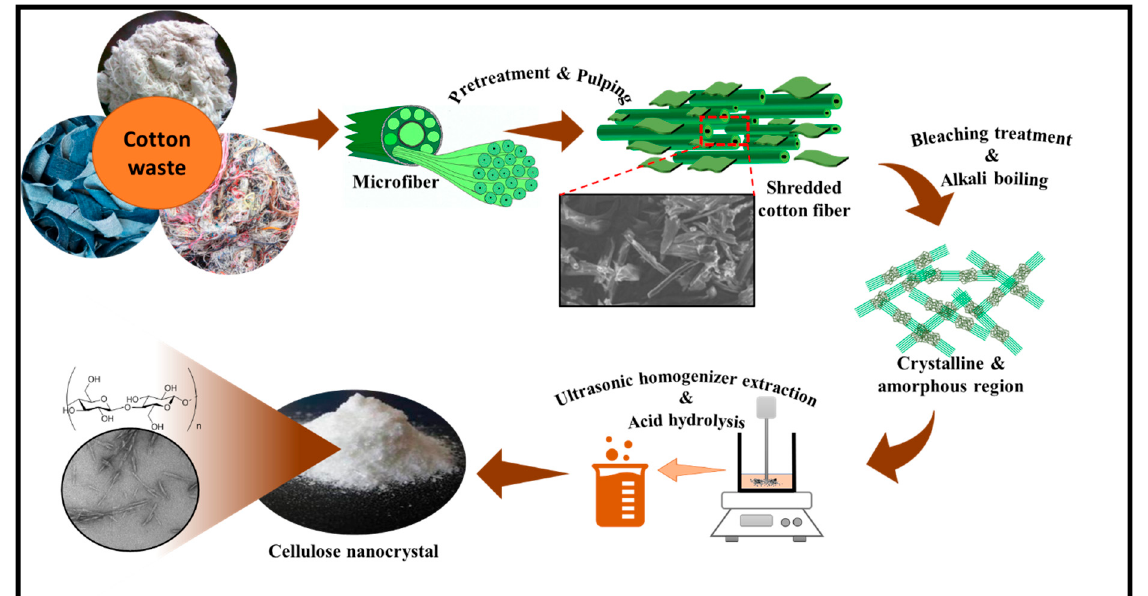
Figure 13. A summary of extraction methods of CNC derived from cotton wastes.